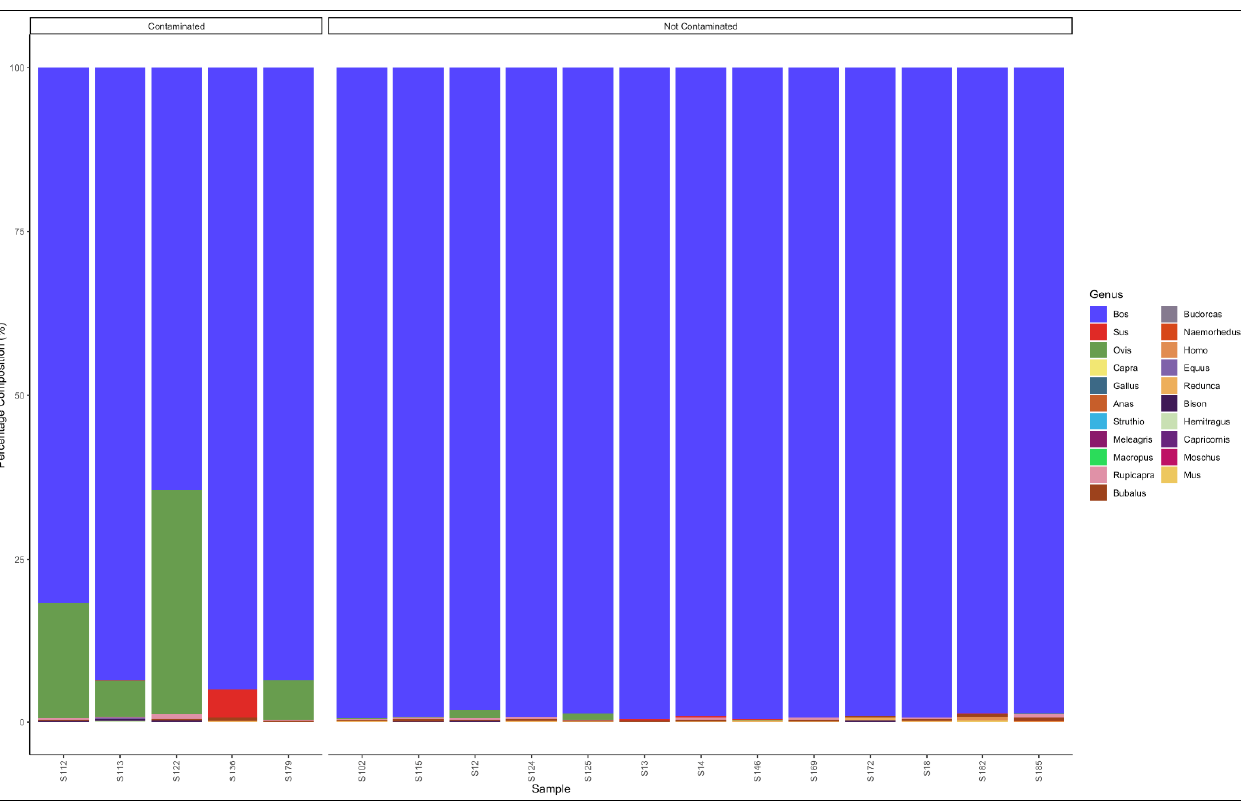
Figure 9. Percentage composition of samples that were labeled as beef patty.